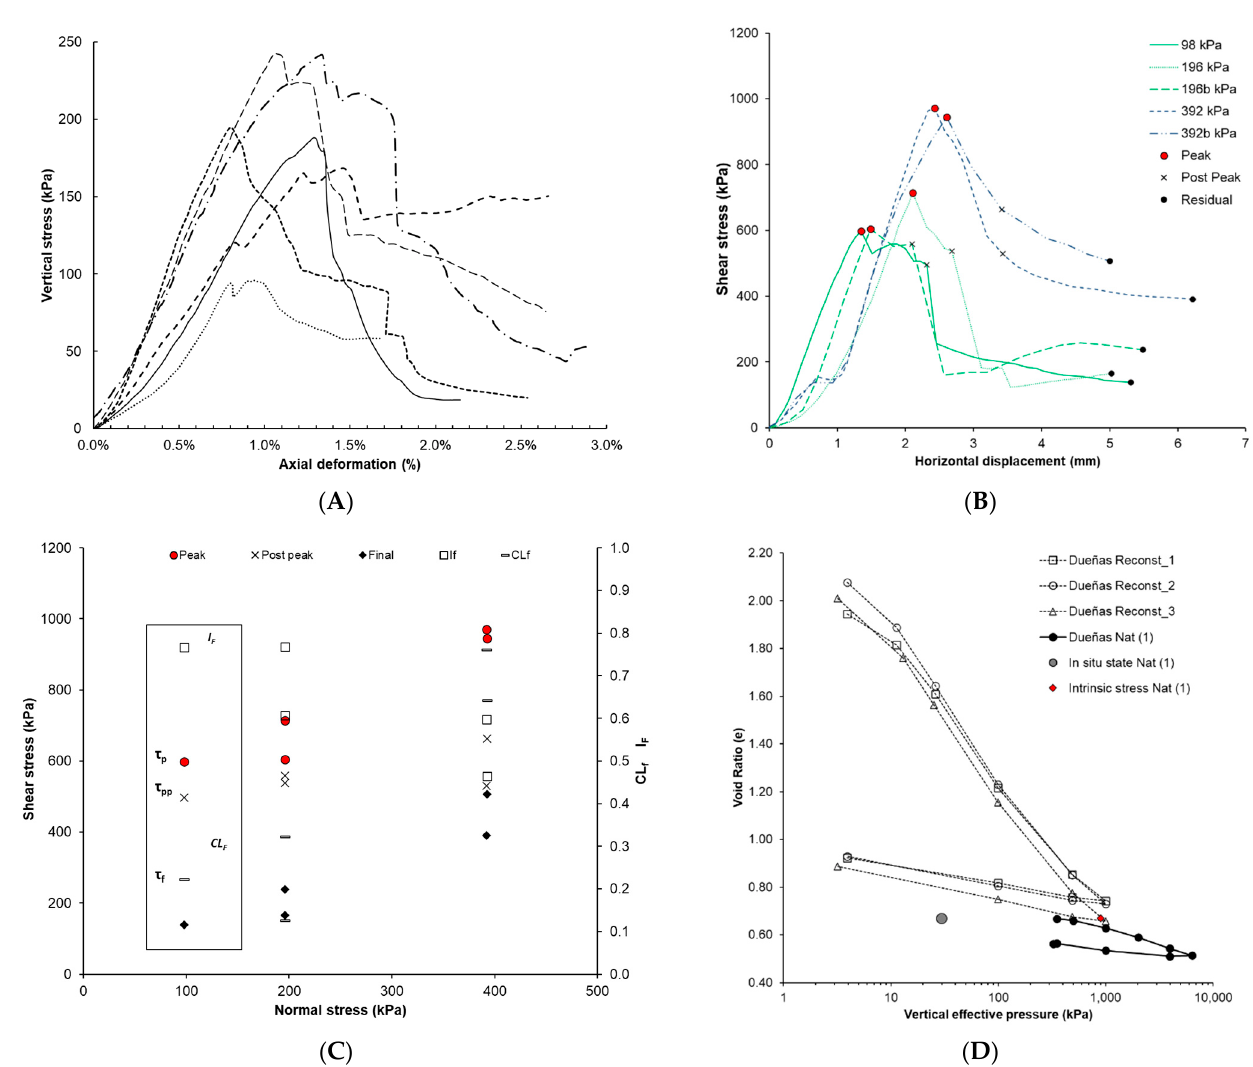
Figure 6. Results of uniaxial compression, direct shear, and oedometer tests. ( A ) Uniaxial compression tests. ( B ) Direct shear tests. ( C ) Normal stress and peak shear stress obtained from the shear tests. ( D ) Oedometer tests with natural and reconstituted samples. Table 5. Compression characteristics as determined by the oedometer tests using natural and reconstituted samples. (e o ),